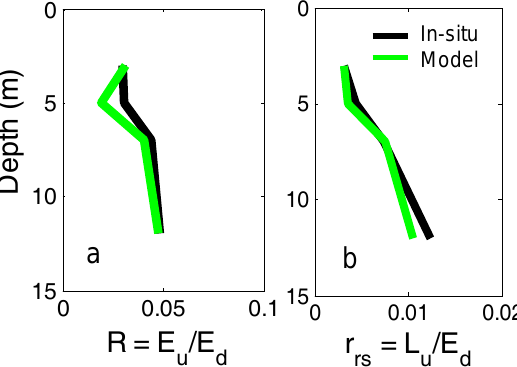
Figure 16. (a) Comparison of the measured and modelled re- flectance ( R = E u /E d ) at 0.555µm along the depth for moderately turbid water. (b) Comparison of the measured and modelled sub- surface remote-sensing reflectance ( r rs = L u / E d ) at 0.555µm along the depth for moderately turbid water. There is good agreement be- tween the modelled and measured reflectance profiles at this